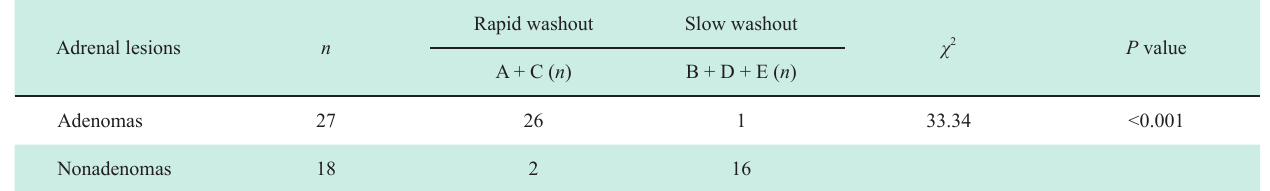
Table 1 Comparison of the types of TD curves in DCE-CT between adrenal adenomas and nonadenomas